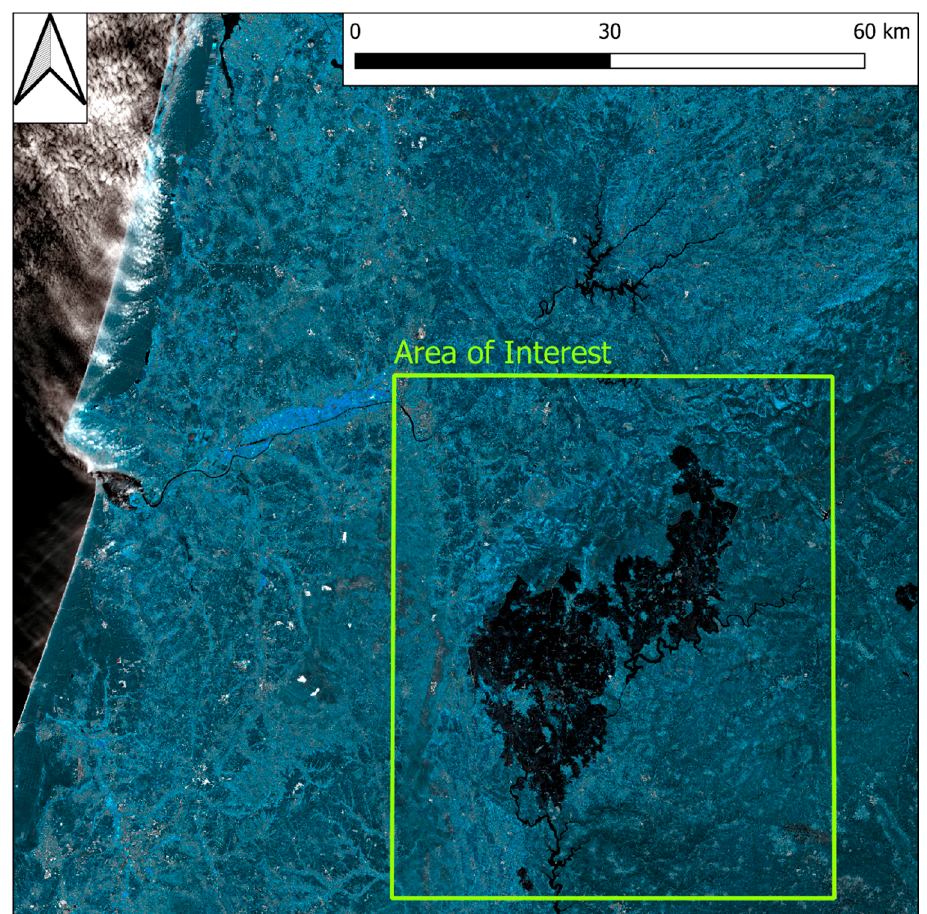
Figure 4. Area of interest (AoI) for biophysical parameter computation compared to Sentinel-2 granule dimension. In transparency is possible to observe the fire affected area. Image acquired on 4 July 2017.